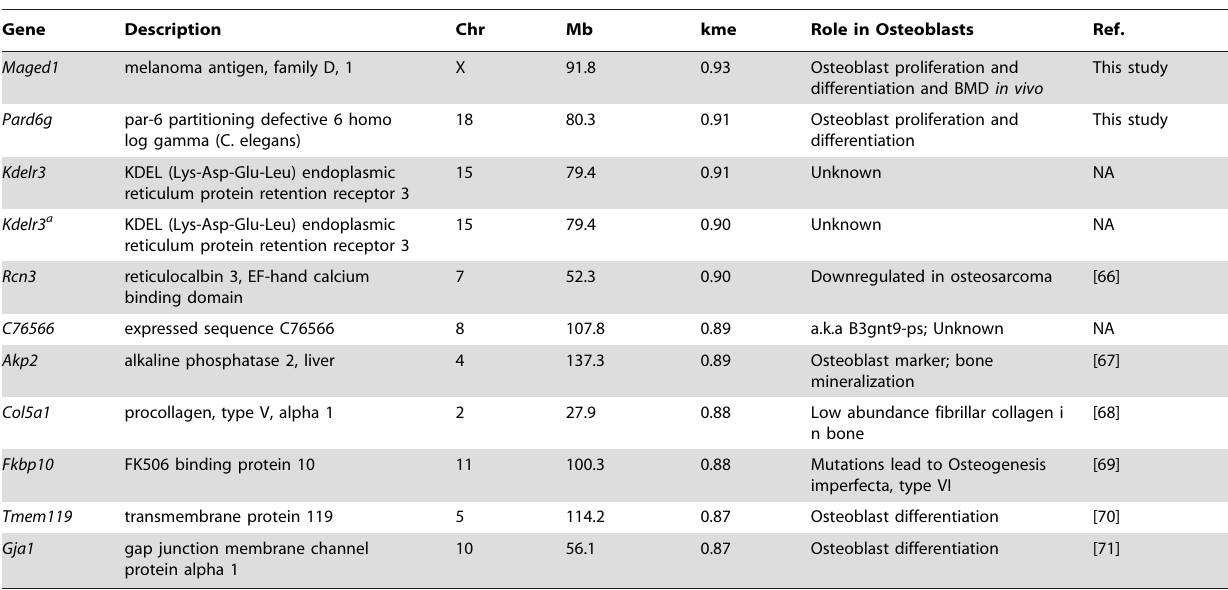
Table 2. Ten most highly connected genes in the